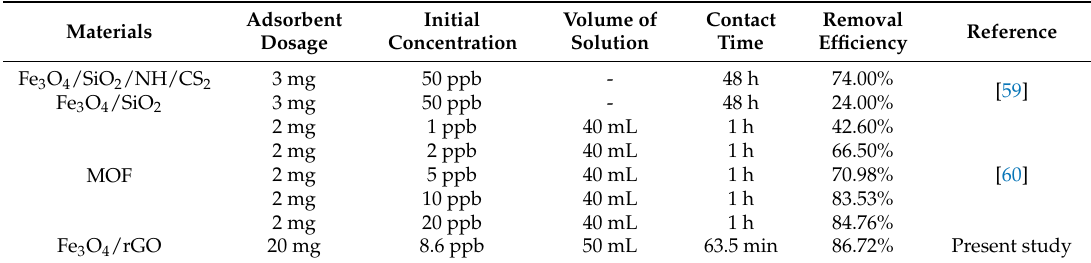
Table 4. The low-concentration mercury removal efficiency by Fe 3 O 4 /rGO composites and other